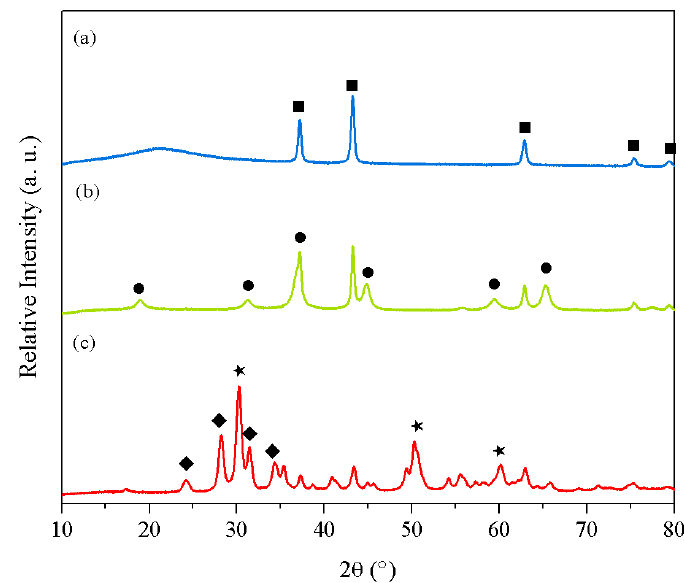
Figure 1. X-ray diffraction (XRD) patterns of 20 wt % nickel catalysts. ( a ) Ni/SiO 2 , ( b ) Ni/MgAl 2 O 4 , and ( c ) Ni-ZrO 2-COP . ZrO 2 Monoclinic phase: ( (cid:7) ), ZrO 2 Tetragonal phase: ( (cid:70) ), MgAl 2 O 4 Spinel: ( ), NiO: ( (cid:4) ).